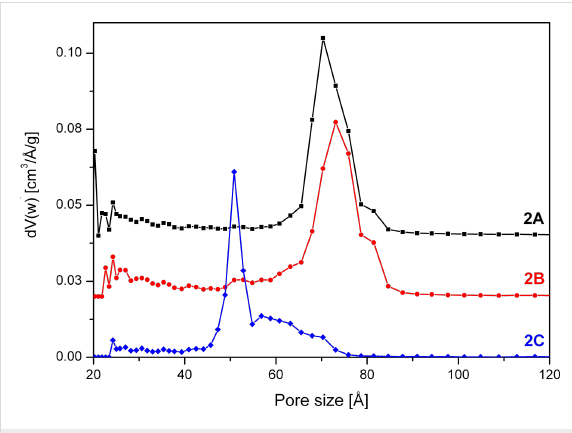
Figure 5: NLDFT pore size distribution of SBA-15 unwashed ( 2A ), after washing with 5 mL ( 2B ) and 30 mL ( 2C ) quantities of solvent calculated from the adsorption branch of the isotherm. The pore size distributions are offset by 0.05 ( 2A ) and 0.025 ( 2B ) cm 3 /Å/g.